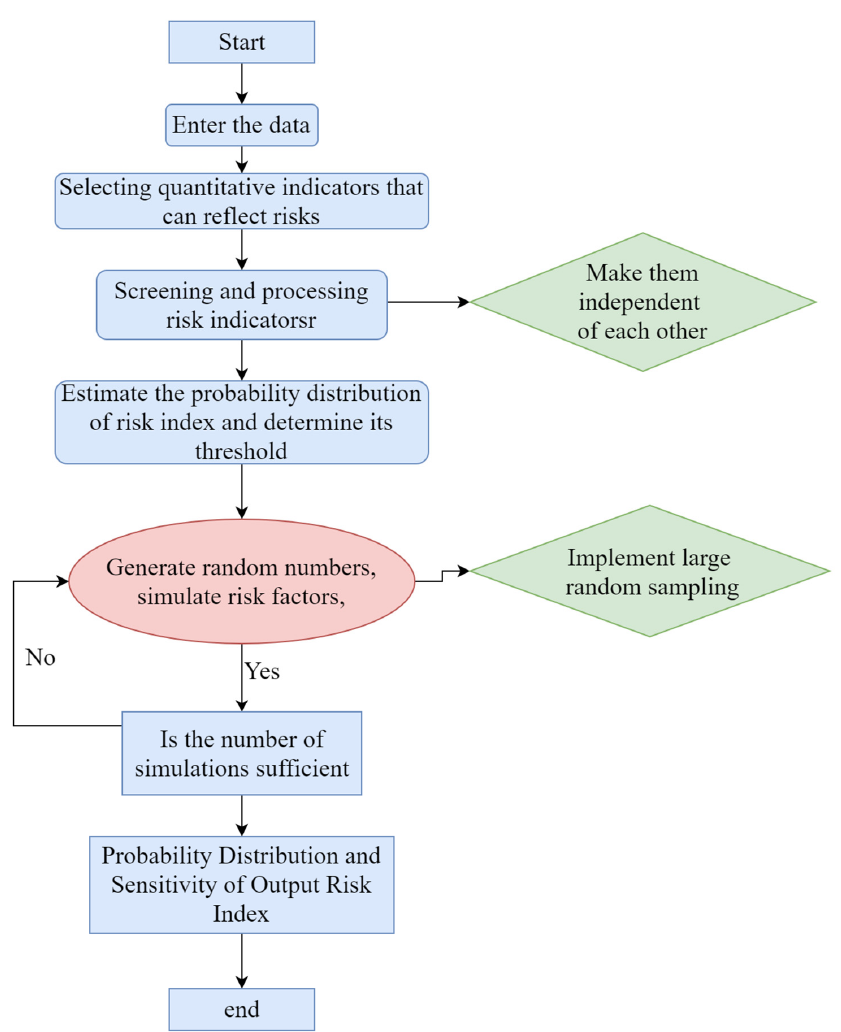
Figure 3. Monte Carlo model operation flowchart.